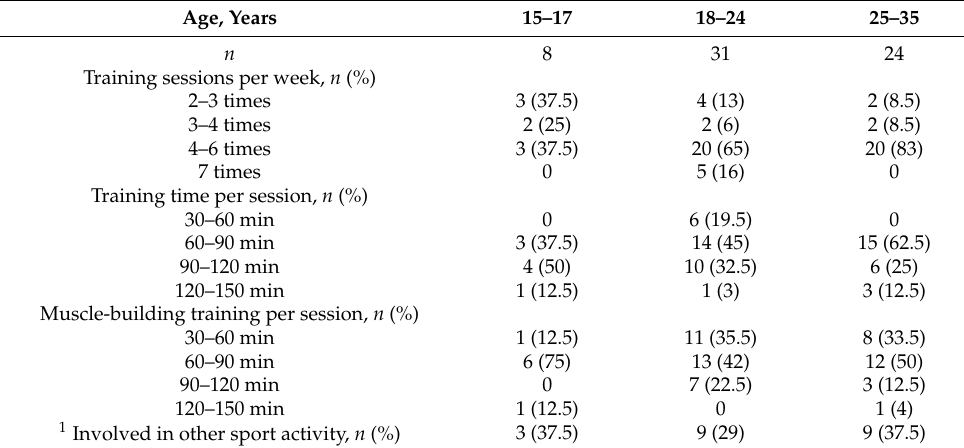
Table 1. Training characteristics (number of training sessions per week, time spent on each training session, specific muscle-building training and involvement in other sport activities) reported by the 15–35-year-old men participating in the survey.